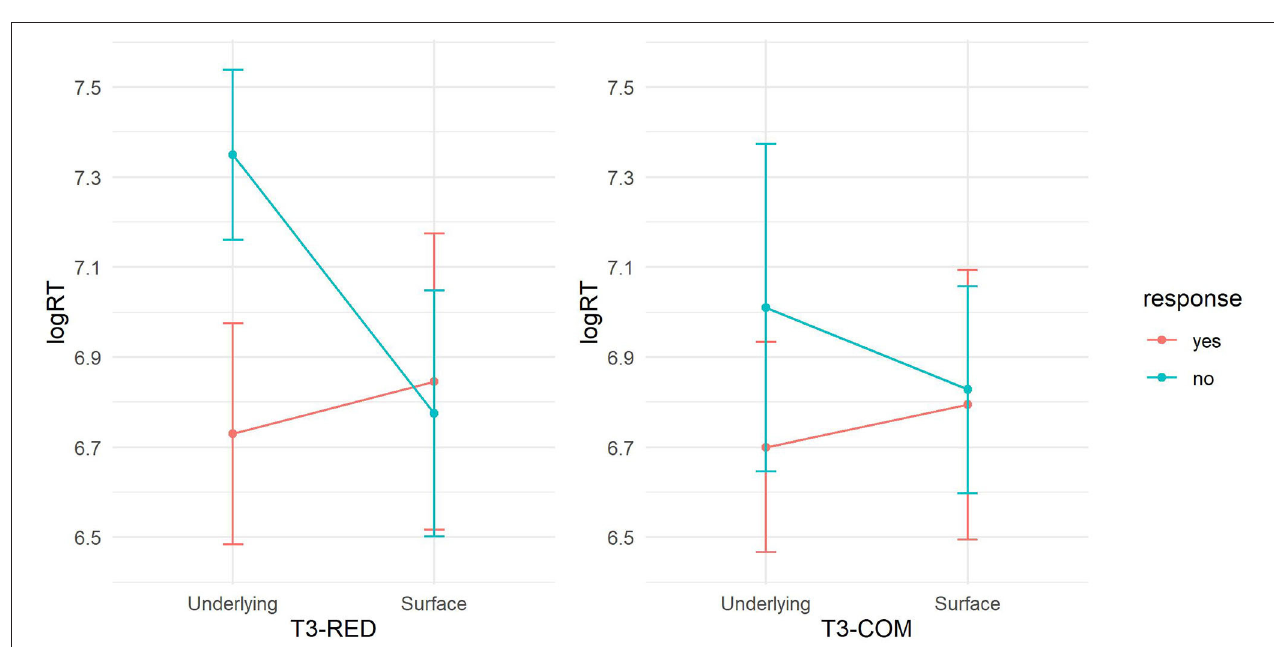
FIGURE 4 | RTs between construction and response